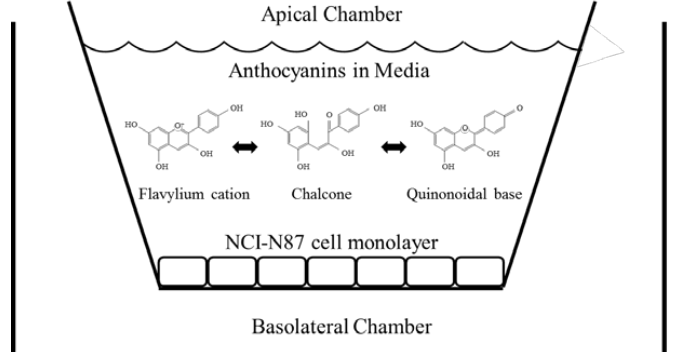
Figure 1. Representation of growing conditions of NCI-N87 cell line and treatments with anthocyanins at different pH conditions.